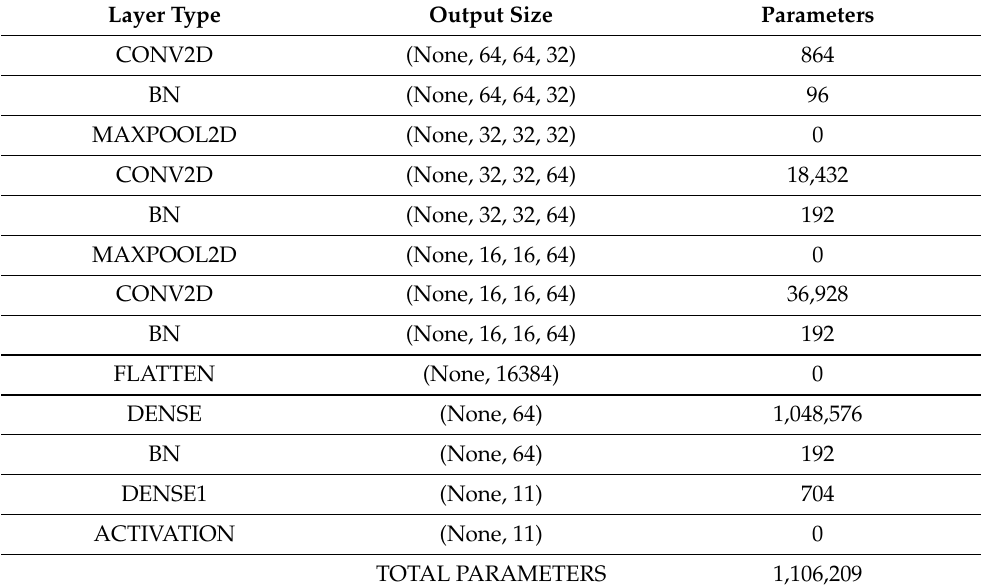
Table 1. A table showing a summary of all the layers of the baseline model